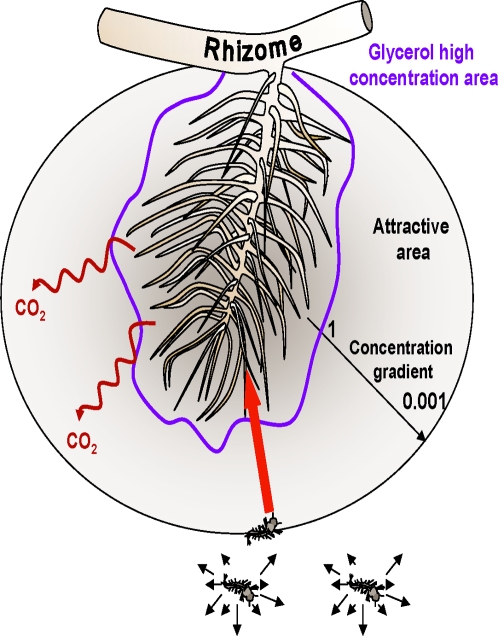
Hypothesis of the establishment of a root exudate gradient in natura.